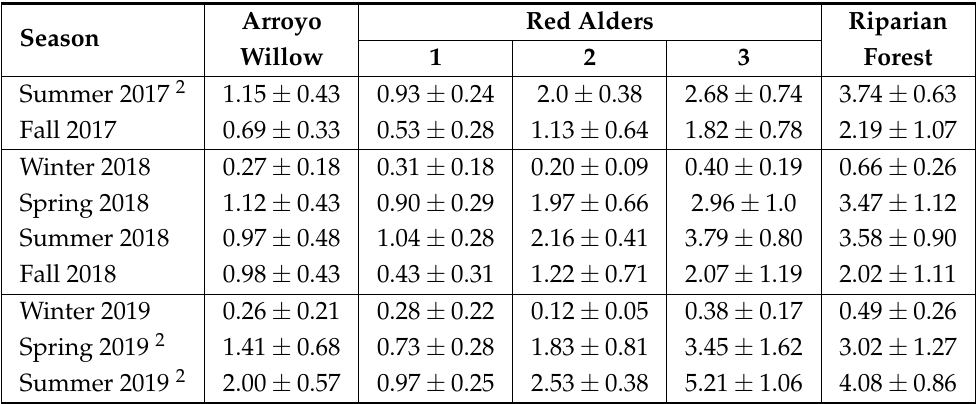
Table 3. Seasonal estimates of mean ET (mm/d), and corresponding mean square errors, of the four instrumented trees and the entire riparian forest over study period.